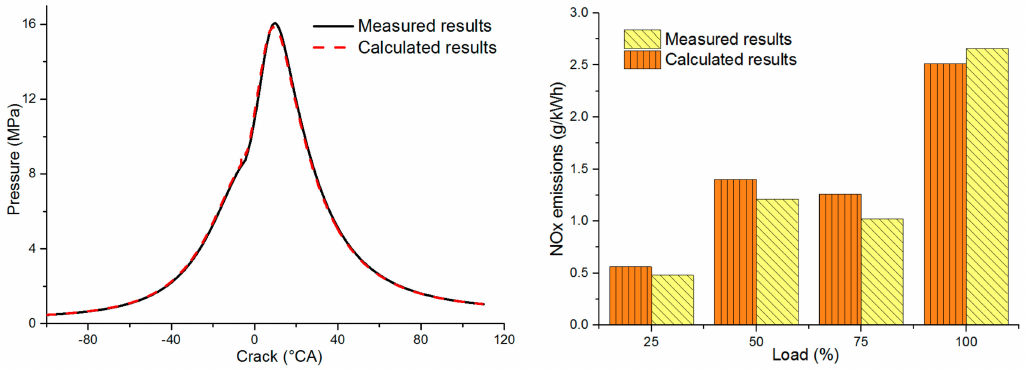
Figure 4. Marine DF engine model verification.